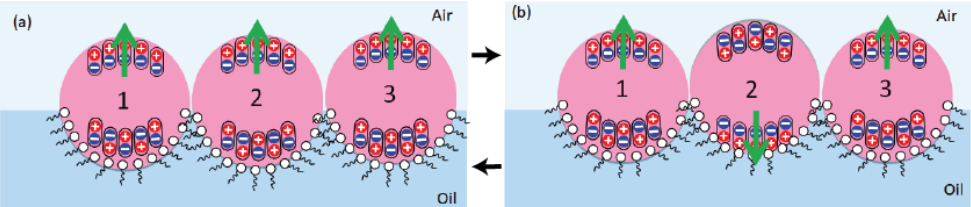
Figure 11. Schematic illustration of dipolar interactions between dipolar droplets. Electric bipoles oriented: ( a ) upwards and ( b )